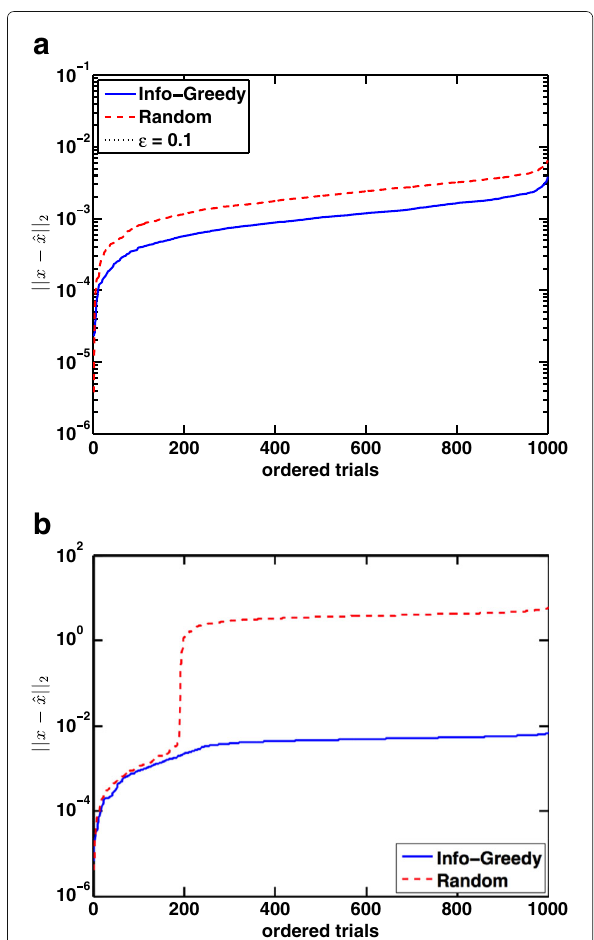
Fig. 5 Sensing a low-rank GMM signal of dimension n = 100 using K = 40 measurements with σ = 0.001, when the covariance matrices are generated a completely randomly, (cid:2) c ∝ RR (cid:2) , R ∈ R n × 3 , R ij ∼ N ( 0,1 ) or b having certain structure, (cid:2) { n , n − 1, ··· ,1 } ) , α ∼ N ( 0,1 ) . The covariance matrices (cid:2)